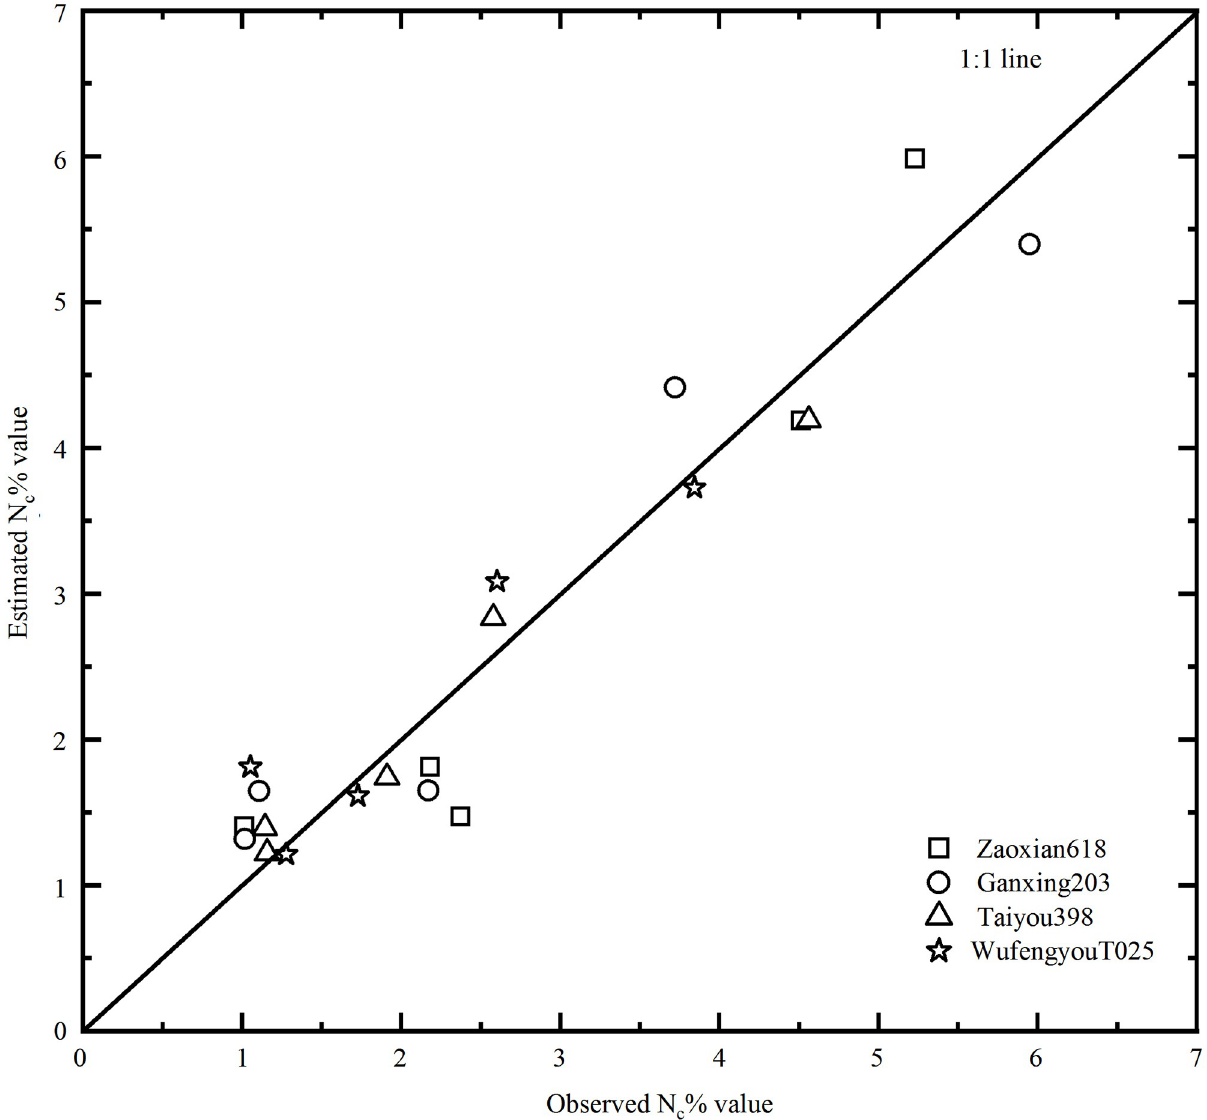
Fig 3. Verification of critical nitrogen concentration dilution curve of double-cropped rice based on leaf dry matter (%).